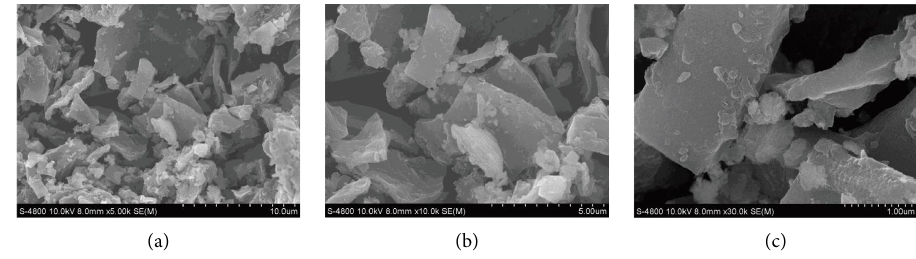
Figure 7: SEM images of MPC-R0.1–2.0 h at diferent magnifcations ( × 5,000, × 10,000, and ×